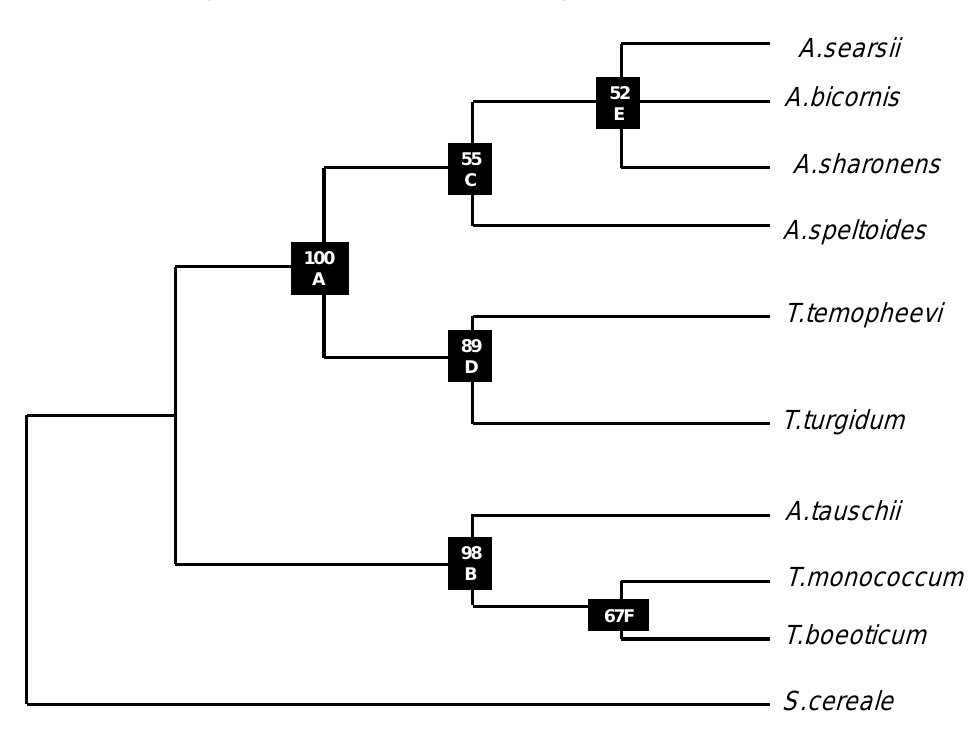
Figure 4. Consensus phylogenetic tree of Triticum and Aegilops species based on the common 500 bp of orf256 sequence and one thousand trials. Bootstraps (the numbers on the branches) indicate the number of times the partition of the species into the two sets, which are separated by that branch, occurred among the trees, out of 999.99